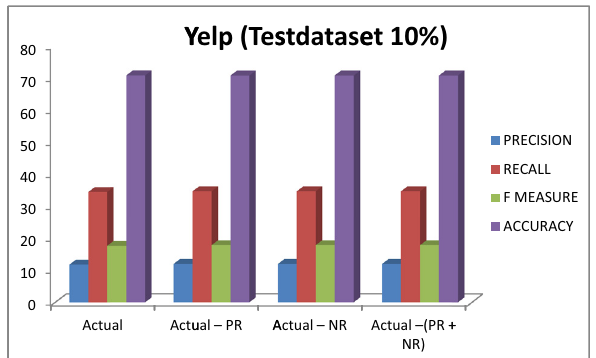
Figure 9: Plot for Yelp 10%